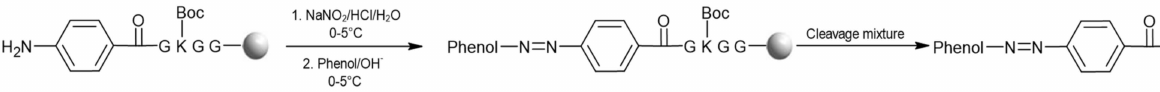
Figure 6. Scheme of the synthesis of azo derivatives used for reactions with phenols.